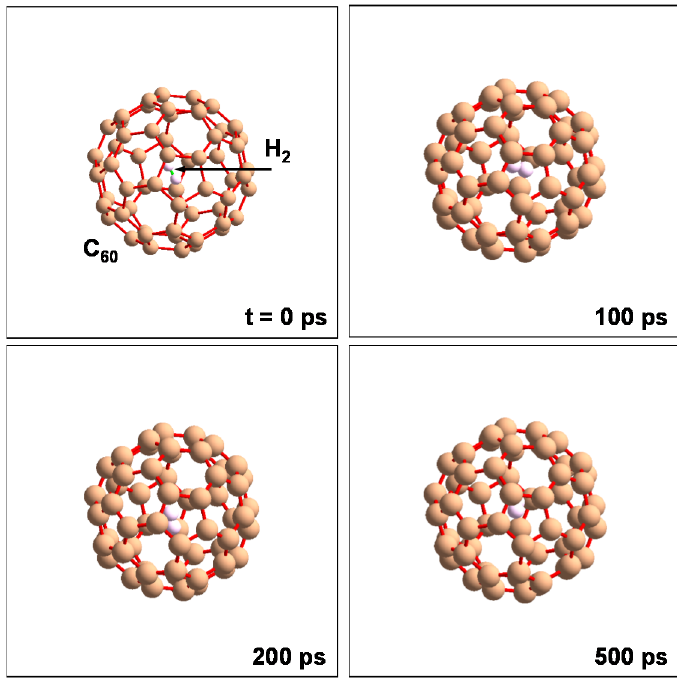
Figure 11. Molecular dynamics calculation to confirm stability of H 2 molecule into C 60 at 298 K and 105 Pa. NTP ensembles and organic potential were used in the calculation.